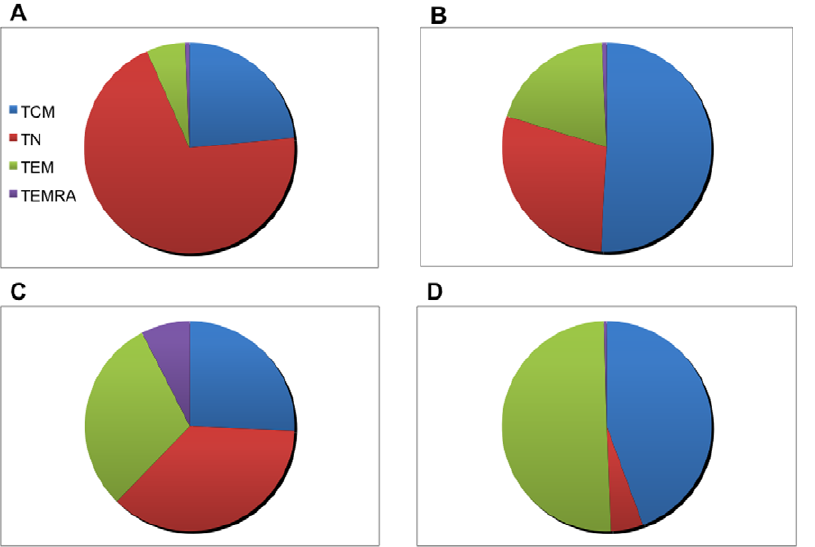
Figure 8. Proportion of resting and MSP1-specific IFN- c producing CD4 T cell subset in children compared to adults. Top left panel (A) shows the proportion of resting CD4 T cell subsets for children # 5 years old (from Fig. 3) with the lower left panel (C) showing the proportion of IFN- c producing CD4 T cell subsets in response to rMSP1 42 stimulation (from Fig. 6). Top right panel (B) shows the proportion of resting CD4 T cell subsets for adults $ 18 years old (from Fig. 3) with the lower right panel (D) showing the proportion of IFN- c producing CD4 T cell subsets in response to rMSP1 42 stimulation (from Fig. 6).